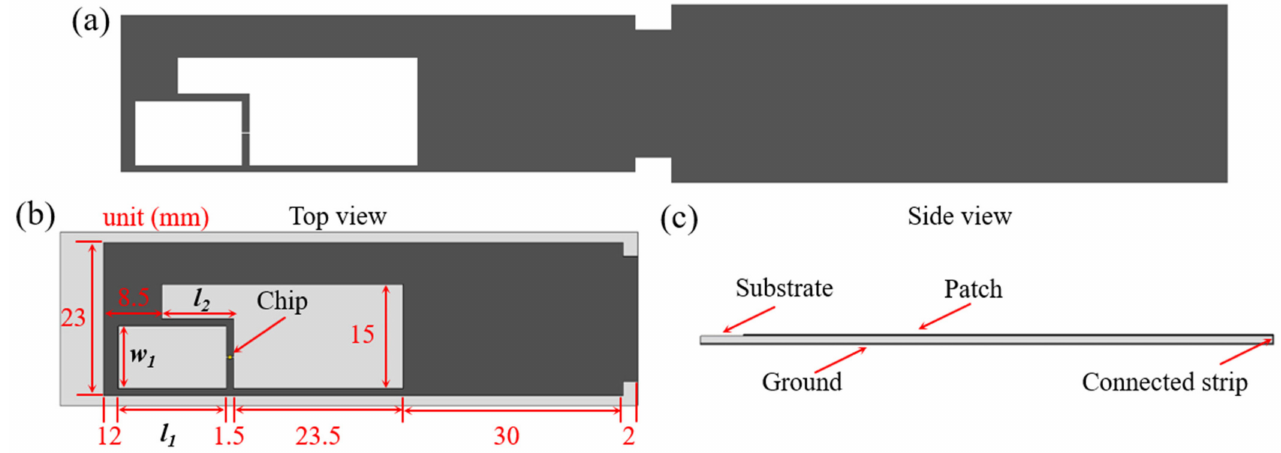
Figure 6. The structure of the proposed antenna: ( a ) tile view of the antenna without wrapping the substrate; ( b ) top view and ( c ) side view of the antenna wrapped around the substrate.